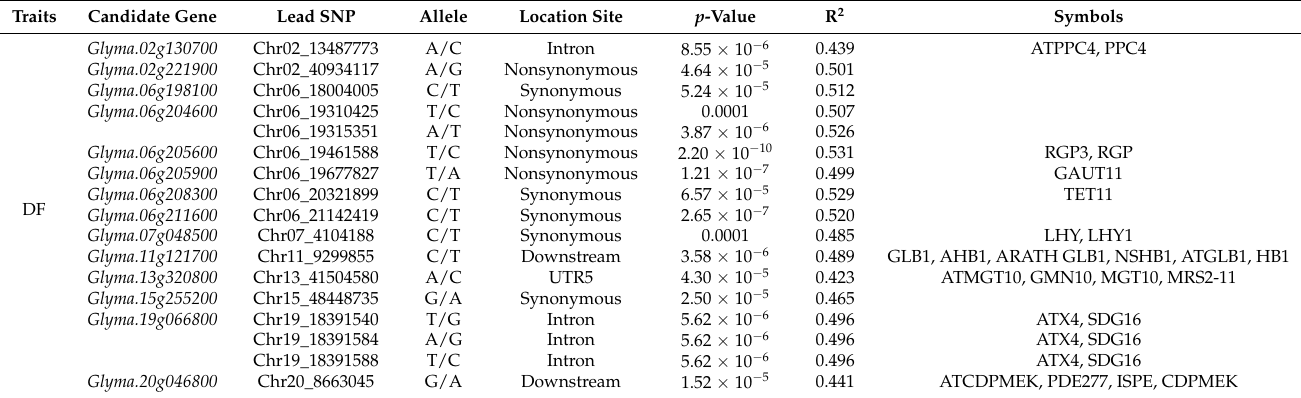
Table 3. Candidate genes and SNPs significantly associated with four traits (DF, FC, NN, and SCC) on the basis of the GWAS